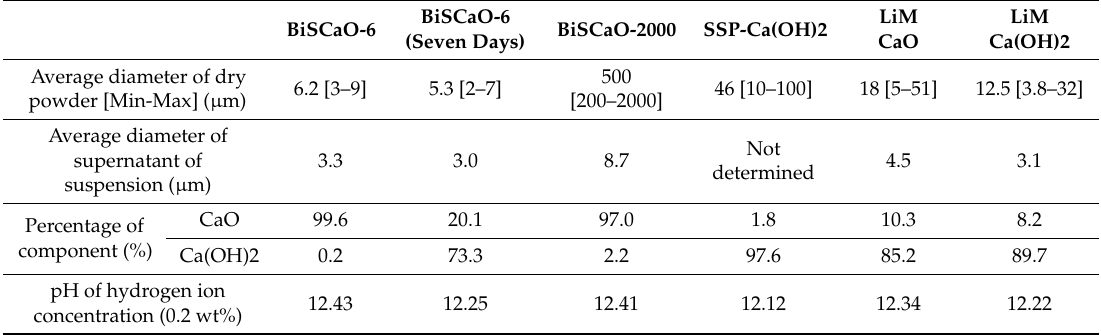
Table 4. Characterization of BiSCaO, SSP-Ca(OH)2, LiMCaO, and LiMCa(OH)2 used in this study.